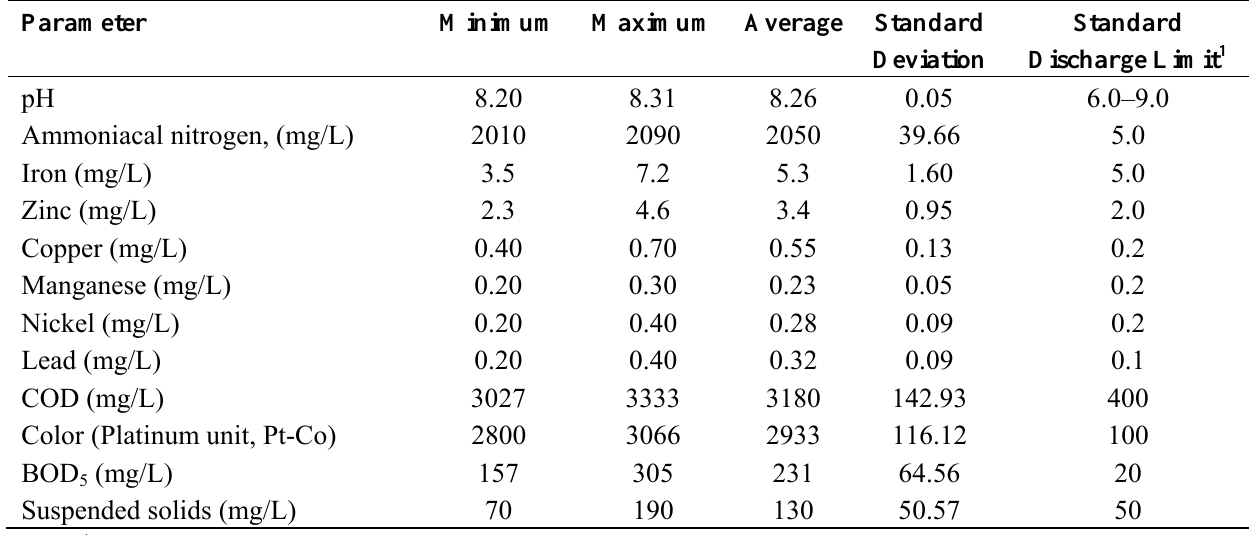
Table 3. Characteristics of the leachate at the Pulau Burung landfill site